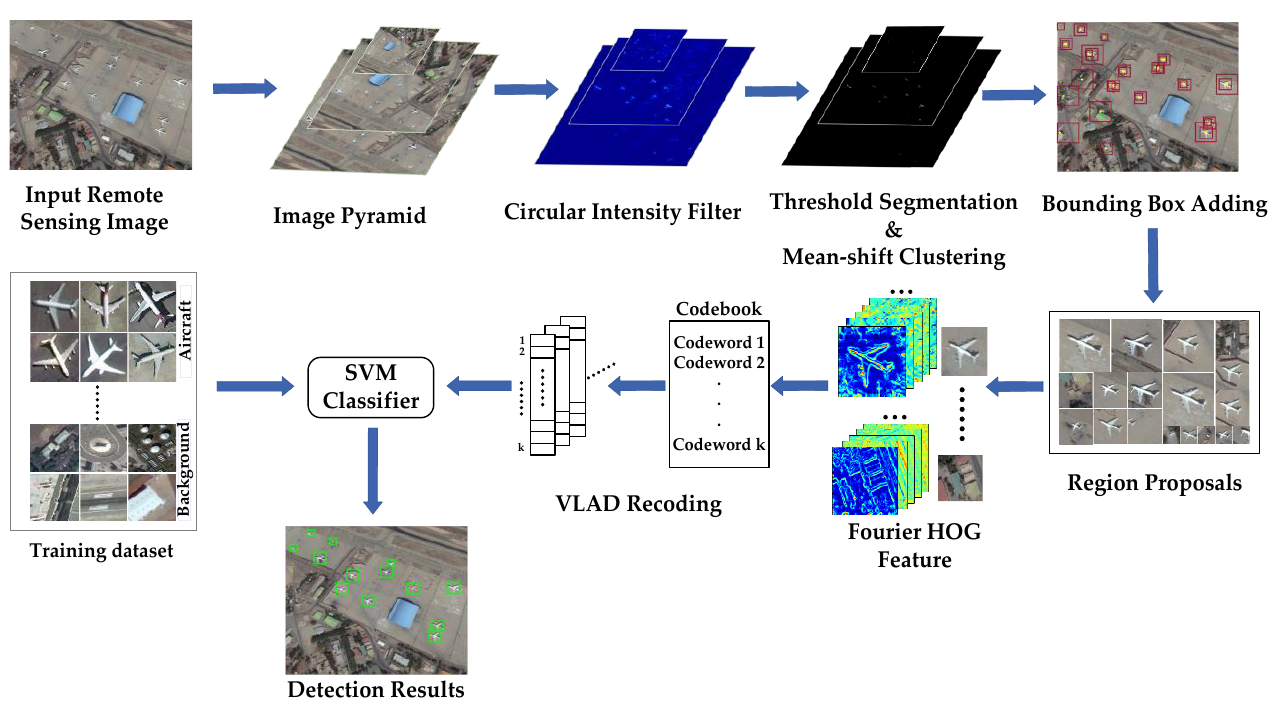
Figure 2. The flowchart of the proposed aircraft detection scheme.